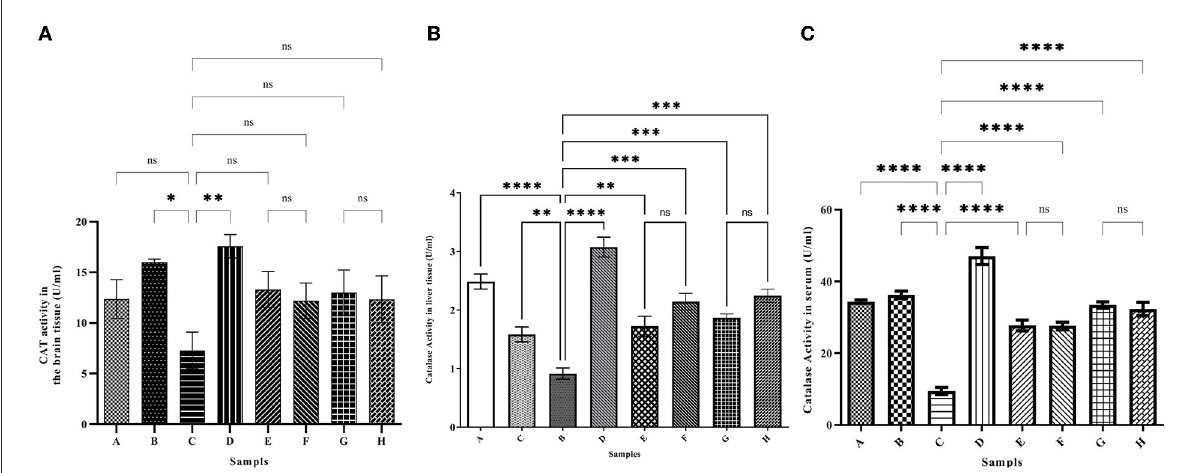
FIGURE6 The activity level of the catalase (CAT) antioxidant enzyme in the brain (A) , liver (B) , and serum (C) . Iron greatly reduces the activity of catalase. Desferal or caffeic acid and ferulic acid improve the activity of catalase enzyme with their antioxidant effect. Group B: normal saline and DFO-receiving group; Group C: iron dextran and normal saline-receiving group; Group D: iron dextran and DFO-receiving group; Group E: low dose caffeic acid-receiving group (30 mg/kg/day); Group F: high dose caffeic acid-receiving group (50 mg/kg/day); Group G: low dose ferulic acid-receiving group (30 mg/kg/day); and Group H: high dose ferulic acid-receiving group (50 mg/kg/day) (Mean ± SD; * p ≤ 0.05, ** p ≤ 0.01, *** p ≤ 0.001, and **** p ≤